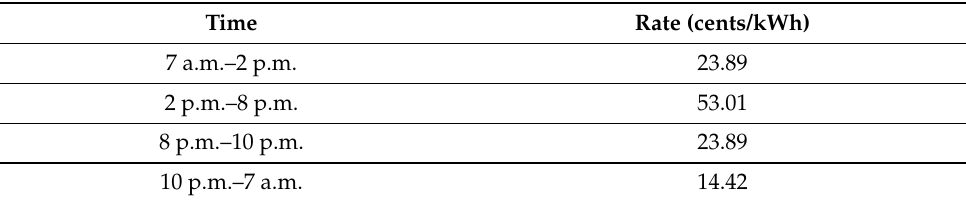
Table 2. ToU residential tariff for Ausgrid distribution zone [49].